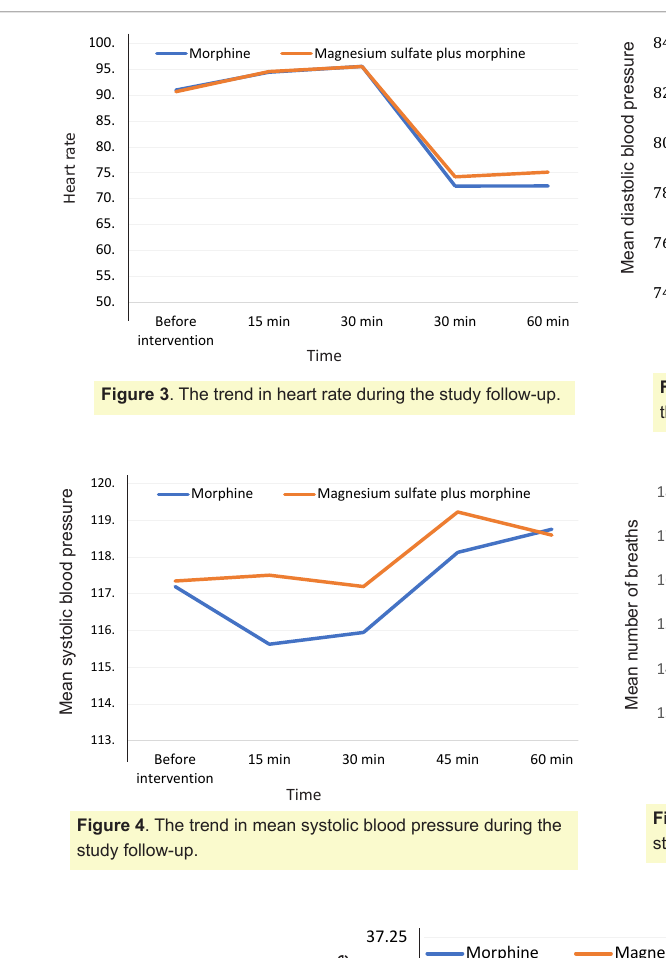
Figure 4 . The trend in mean systolic blood pressure during the study follow-up.